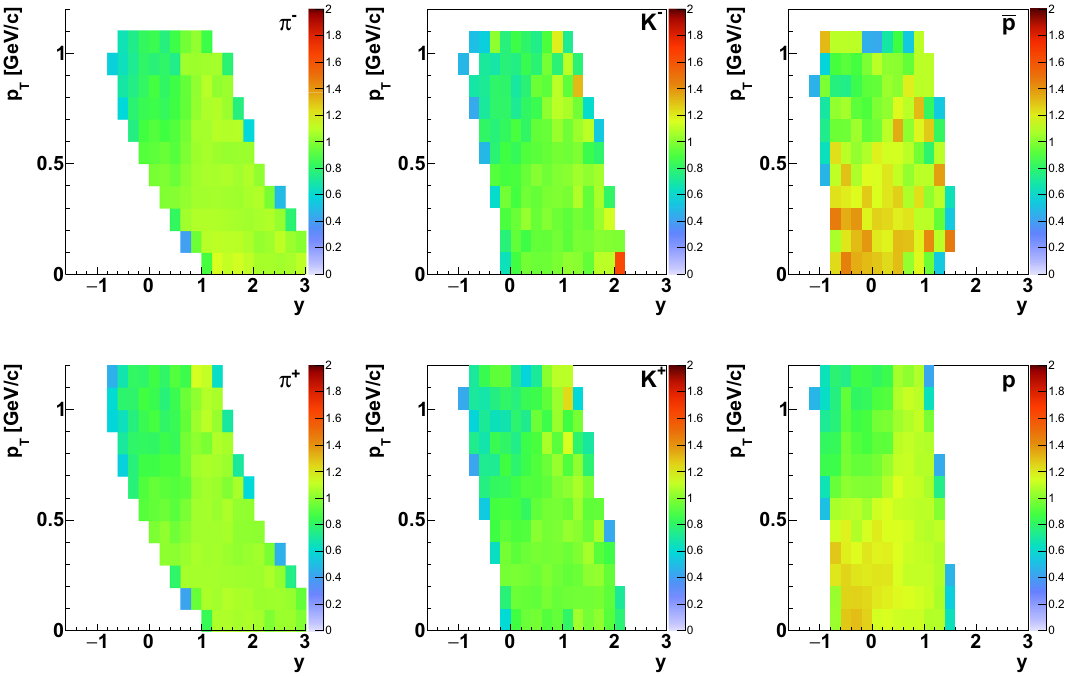
Fig. 13 Correction factors C − 1 for the d E / d x identification method for positively and negatively charged pions, kaons and protons in p + p i interactions at 158 GeV /